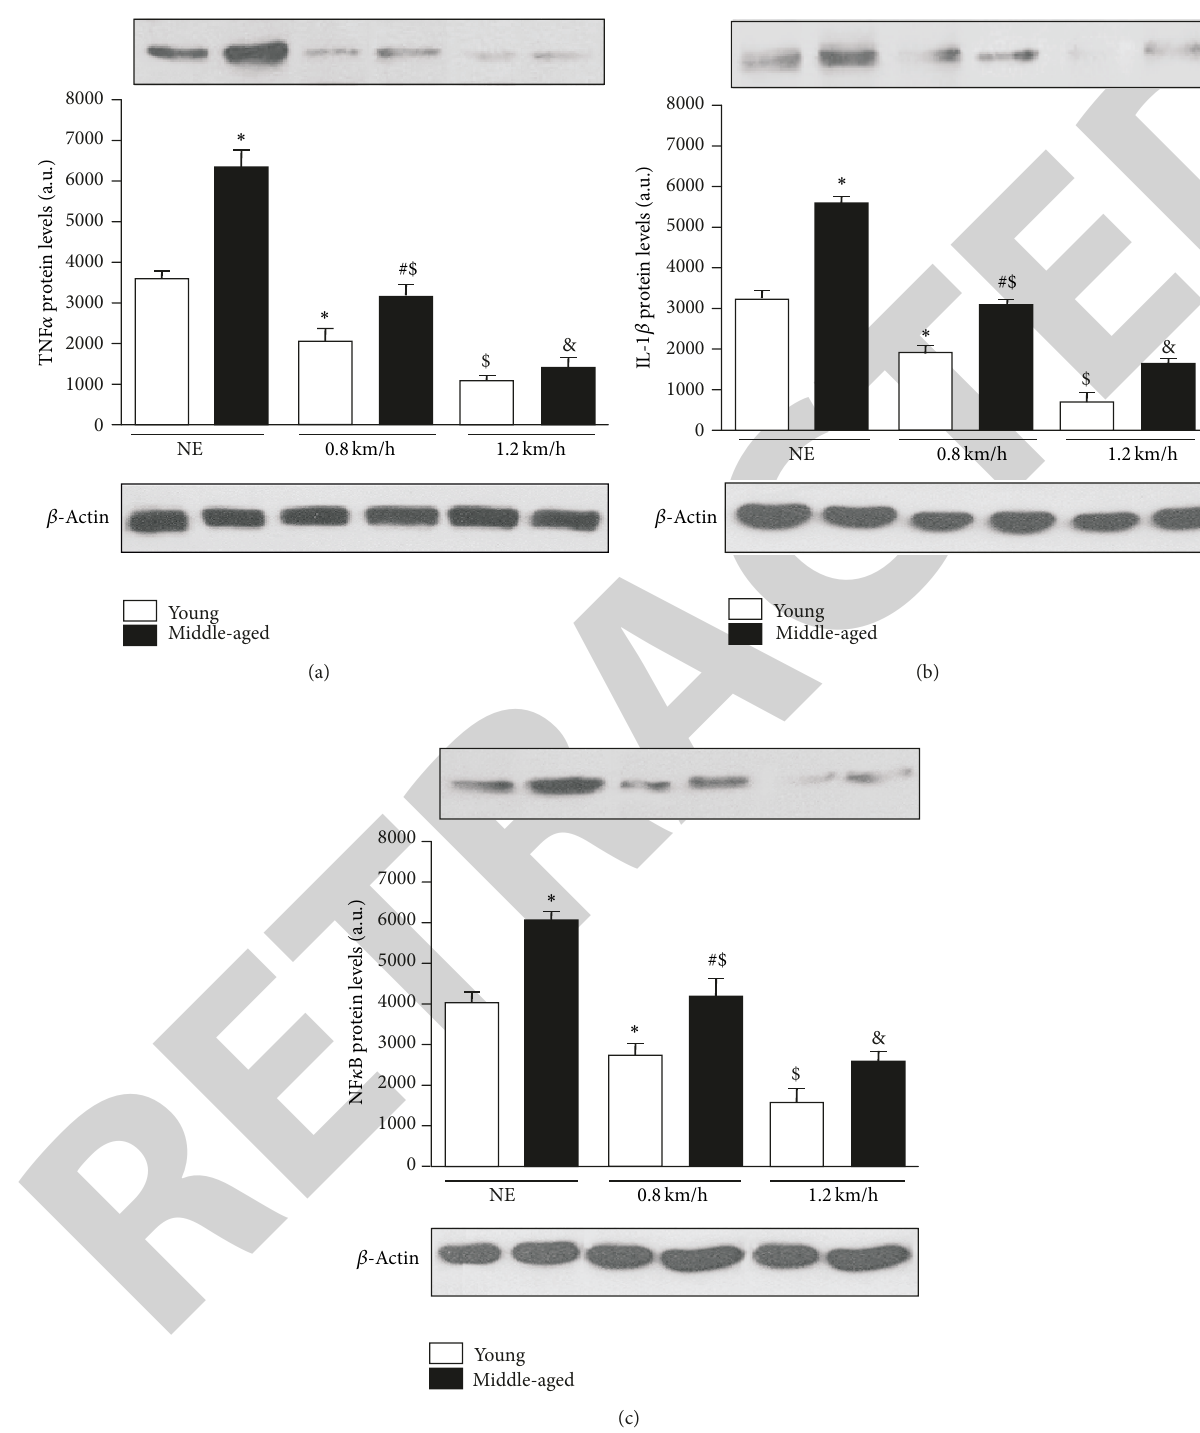
Figure 1: Effects of exercise protocols performed in different intensities on the TNF- 𝛼 , IL-1 𝛽 , and NF- 𝜅 B protein levels in the quadriceps of young and middle-aged rats. Protein levels of TNF- 𝛼 (a), IL-1 𝛽 (b), and NF- 𝜅 B (c). Upper panels show representative blots of these proteins. Lower panels show representative blots of 𝛽 -actin (a)–(c) protein levels. The results of scanning densitometry are expressed as arbitrary units. Bars represent means ± SEM of six rats. ∗ 𝑃 < 0.05 versus young NE rats, # 𝑃 < 0.05 versus middle-aged NE rats, $ 𝑃 < 0.05 versus young rats at 0.8 km/h, and & 𝑃 < 0.05 versus middle-aged rats at 0.8